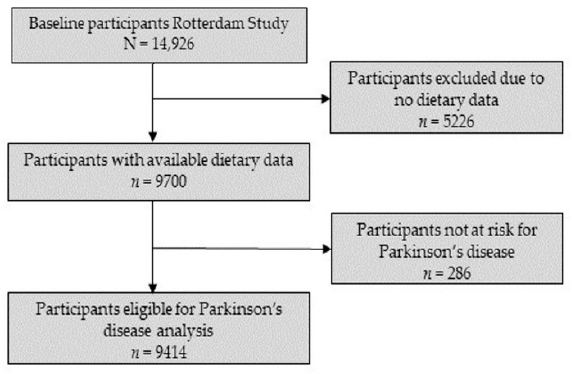
Figure 1. Flowchart for selection of study